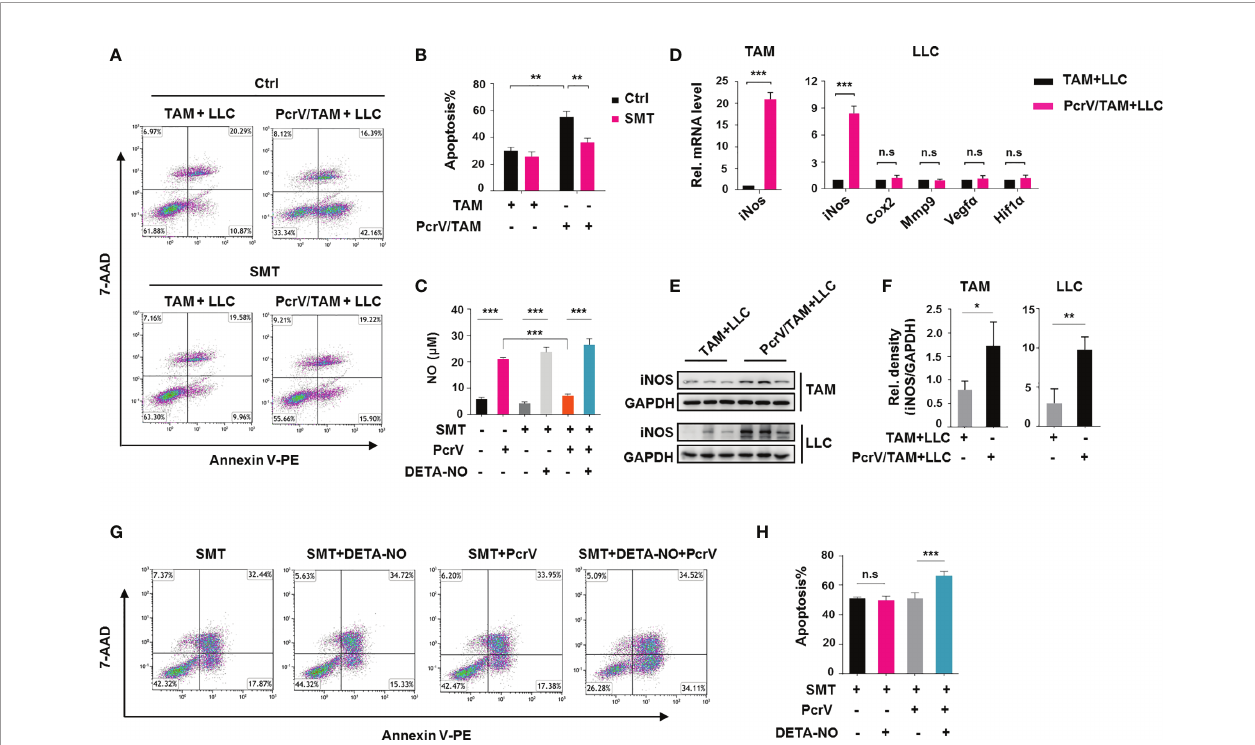
FIGURE 4 | PcrV-primed tumor-associated macrophages (TAMs) induce the apoptosis of tumor cells by enhancing nitric oxide (NO)-associated cytotoxicity in vitro . Bone marrow-derived macrophages (BMDMs) were treated or not with PcrV (10 m g/ml) for 24 h and then co-cultured with LLC cells for another 24 h For the inhibition of nitric oxide (NO) production, BMDMs were pretreated with S -methyl thiourea (SMT; 0.5 mM) for 2 h followed by exposure to PcrV. To increase the NO level, the culture medium was supplemented with the NO donor DETA-NO (20 m M). (A, B) LLC cell apoptosis was detected by FACS using Annexin V/7-AAD staining. (C) The NO level in the macrophage-LLC cell co-culture medium was detected using Griess reagent. (D) Gene expression levels in TAMs and LLC cells were analyzed by RT-qPCR. (E, F) Protein expression was analyzed by Western blotting. (G, H) Apoptosis in LLC cells was analyzed by FACS. Data were expressed as means ± SD and analyzed by unpaired Student ’ s t -test. * p < 0.05, ** p < 0.01, and *** p < 0.001. Rel. mRNA level indicates relative mRNA level. LLC, Lewis lung cancer; FACS, fl uorescence-activated cell